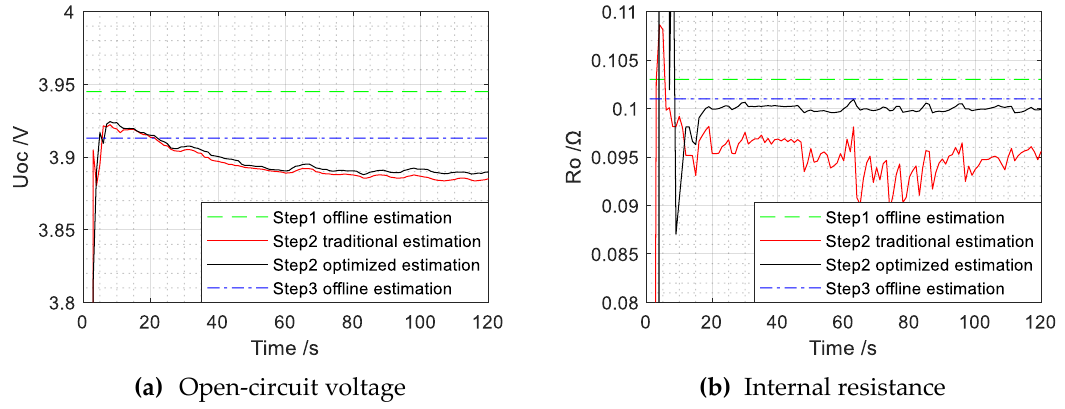
Figure 11. The parameter trajectories obtained by the optimized estimation method with sampling delay at 0 ms.